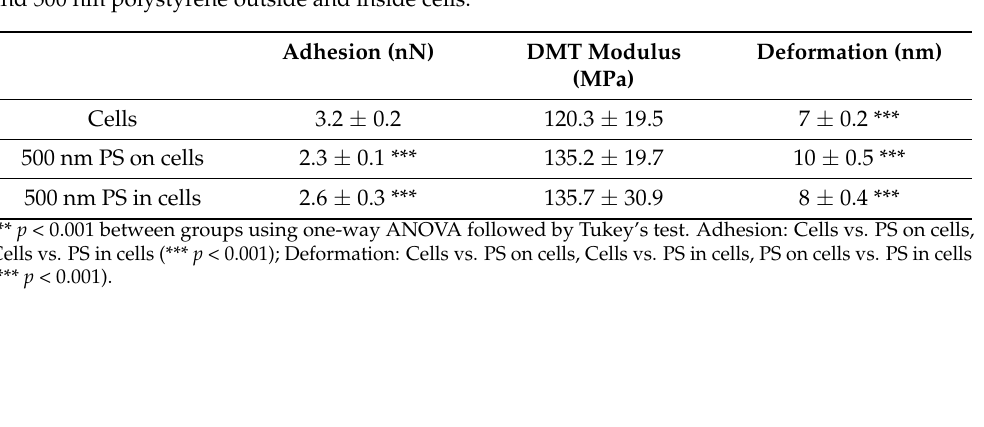
Figure 6. AFM images of topography ( A , E ), adhesion ( B , F ), Young’s modulus (DMT modulus) ( C , G ), and deformation ( D , H ) showing the distribution of 500 nm polystyrene particles in HSF after 24 h co-incubation. The yellow arrows indicate polystyrene particles on the cell surface, and the blue arrows indicate particles inside the cells. Table 1. Nanomechanical parameters (adhesion, DMT modulus, and deformation) of HSF surface and 500 nm polystyrene outside and inside